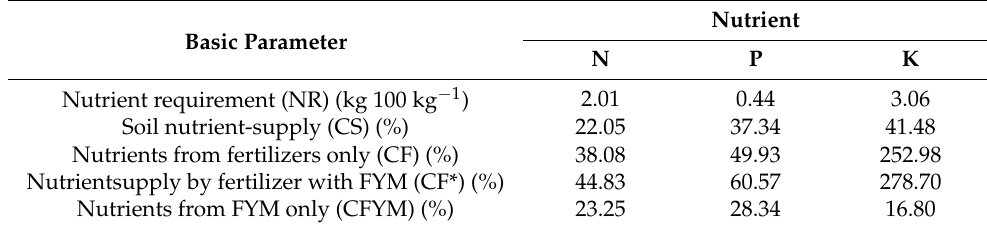
Table 5. Basic parameters for calculating fertilizer requirement, with and without FYM, for the targeted yield of DSR.